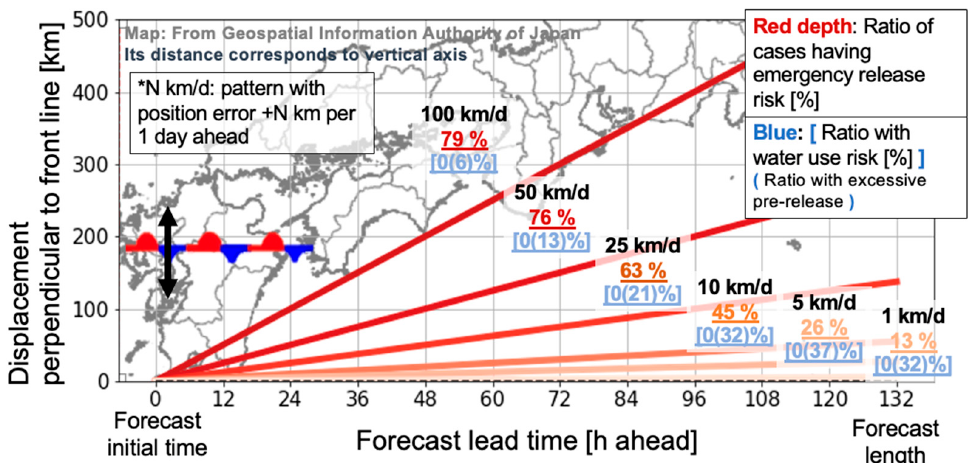
Figure 21. Another version of Figure 20 shown on the forecast patterns’ variations. Ratio (%) of cases with an emergency release risk in all pre-release front cases (red) and a water use risk in all pre-release and quasi-pre-release front cases (blue) when using rainfall forecasts with various position errors of the rainfall zone. N km/d: a pa tt ern with position error +N km per 1 day ahead.